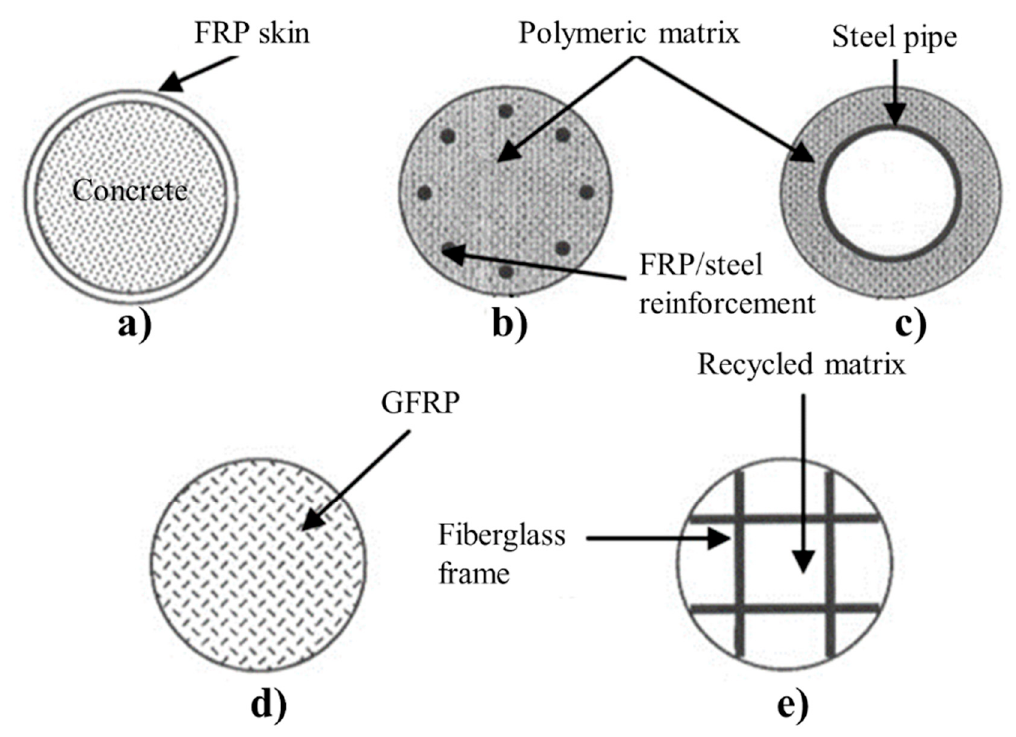
Figure 8. Composite pile types: ( a ) concrete-filled FRP pipe, ( b ) SRP pipe, ( c ) steel pipe core pipe, ( d ) fiberglass reinforced plastic pile, ( e ) fiberglass pultruded pipe pile [65].